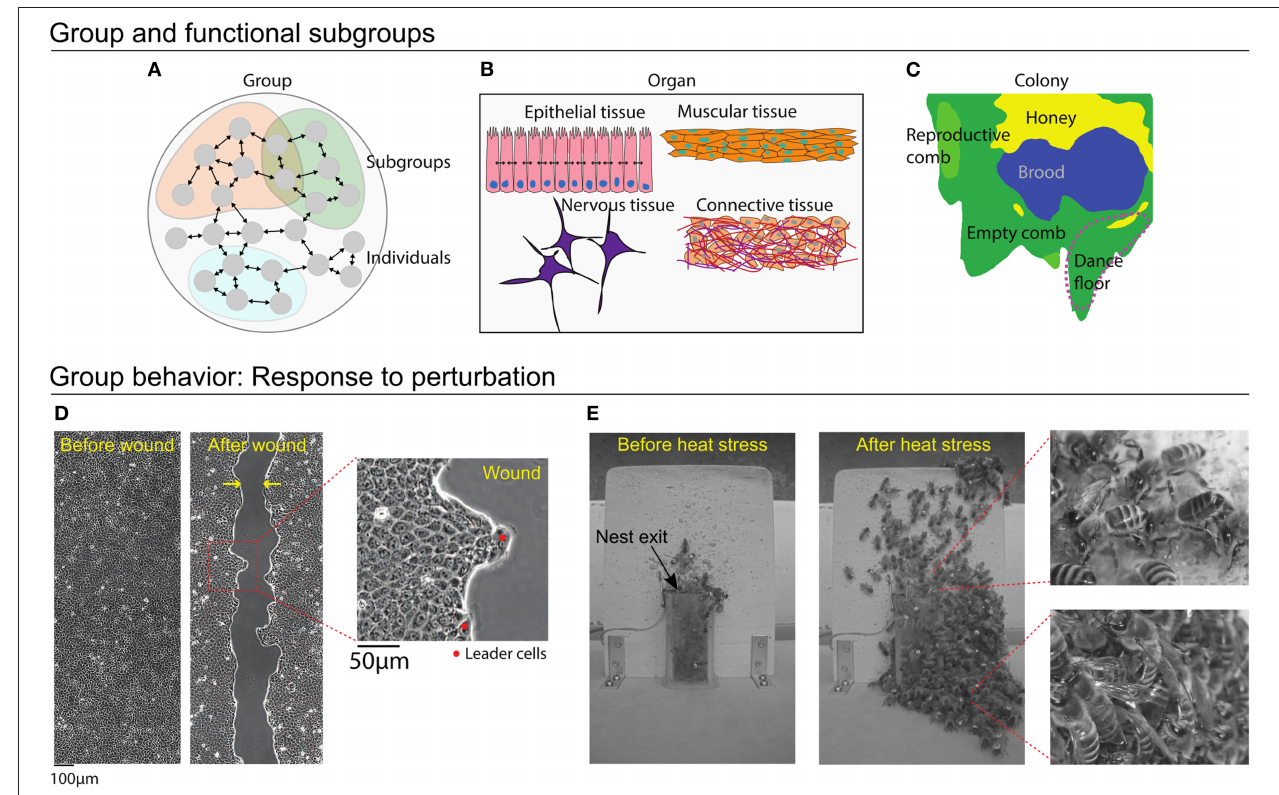
FIGURE 2 | Cellular systems and honey bee colonies. (A) A group is made up of multiple individuals, with inclusions defined by genetic, reproductive, spatial, or functional factors. Within a group, divisions into subgroups can represent individuals that perform specific functions. (B) Scales of organization within an organ. Cells of a certain type form subgroups, each of which performs specific functions. These tissues combine to form an organ. (C) Nest structure illustrates functional subgroups in a honey bee colony. This nest has been organized into areas designated for brood care, honey storage, rearing male reproductives, and a dance floor. Workers organize themselves according to these nest areas, with young bees caring for brood and old bees advertising foraging sites on the dance floor. (D,E) Response to perturbation case study, where the group must restore homeostasis. (D) After being cut, epithelial cells quickly respond with directed motion to heal the wound. Leader cells are larger and more polarized than the other cells, and they guide the cells to move in the direction of the wound. (E) A honey bee colony responds to heat stress. Before the heat stress (left), few bees have evacuated the nest, but soon after, hundreds of bees will exit the nest (center). Some workers continue fanning at the entrance (right, top), whereas others simply evacuate (right,